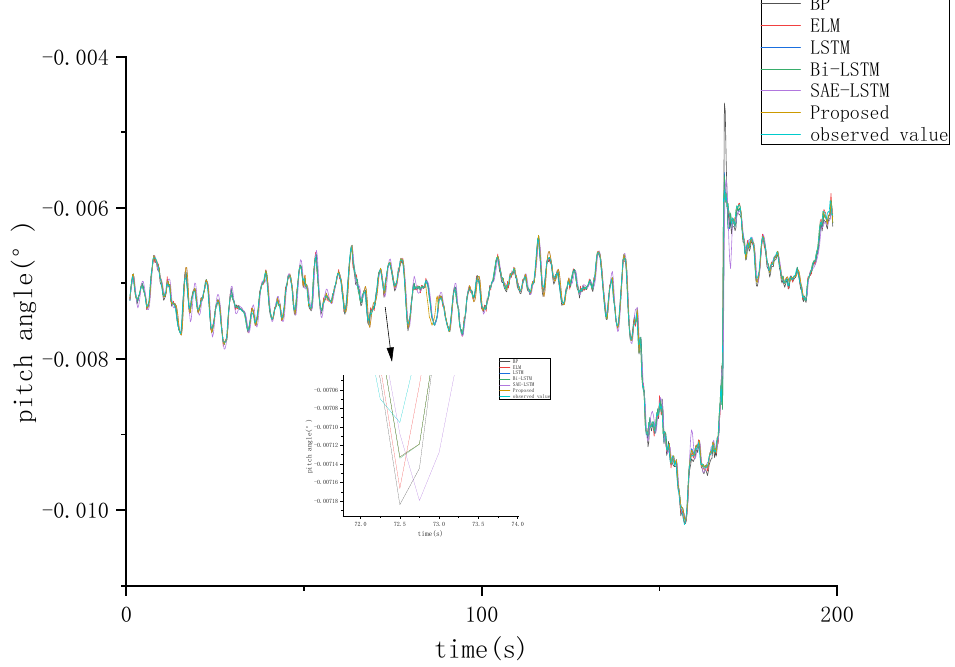
Figure 18. Pitch angle prediction results in the training set of Dataset